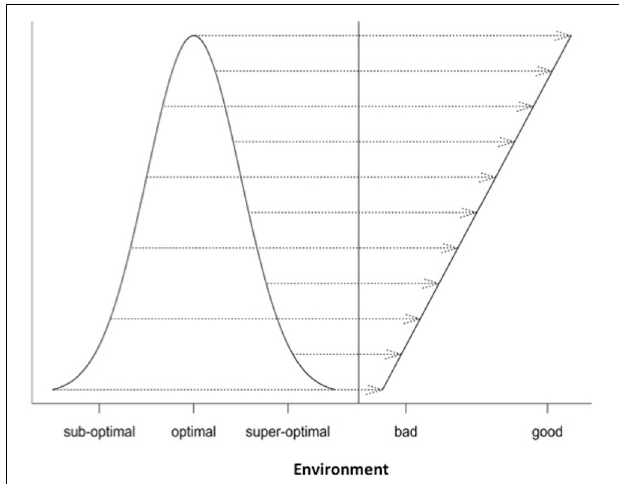
FIGURE 5 | A demonstration of masking true (non-linear) responses to environmental changes if a linear function is